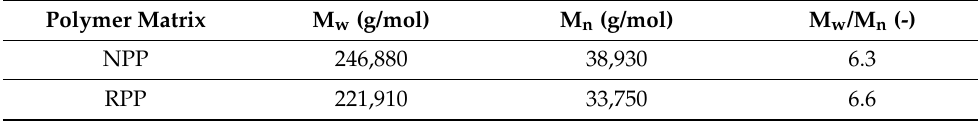
Figure 1. The molecular weight distribution of neat (NPP) and recycled (RPP) polypropylene matrix materials. Table 2 . High-temperature gel permeation chromatography (H-GPC) results.